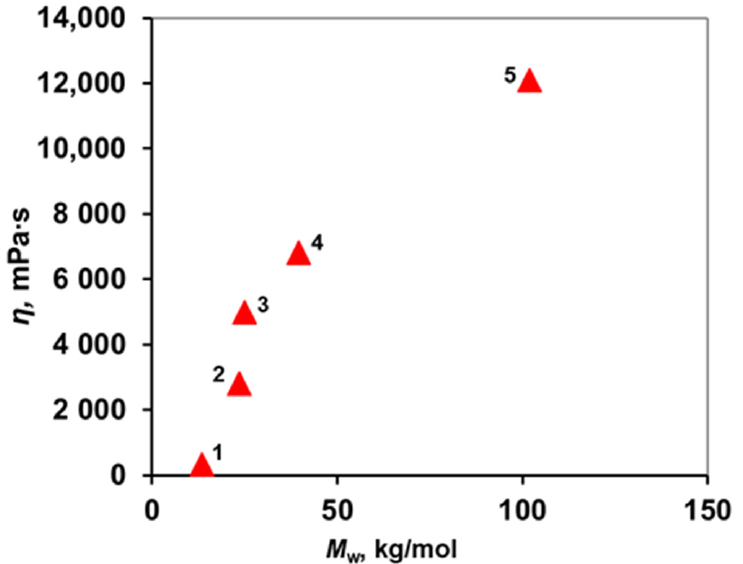
Figure 4. Dependence of the viscosity of PPSU 20 wt. % solutions in NMP on their molecular weight at 22 °C.